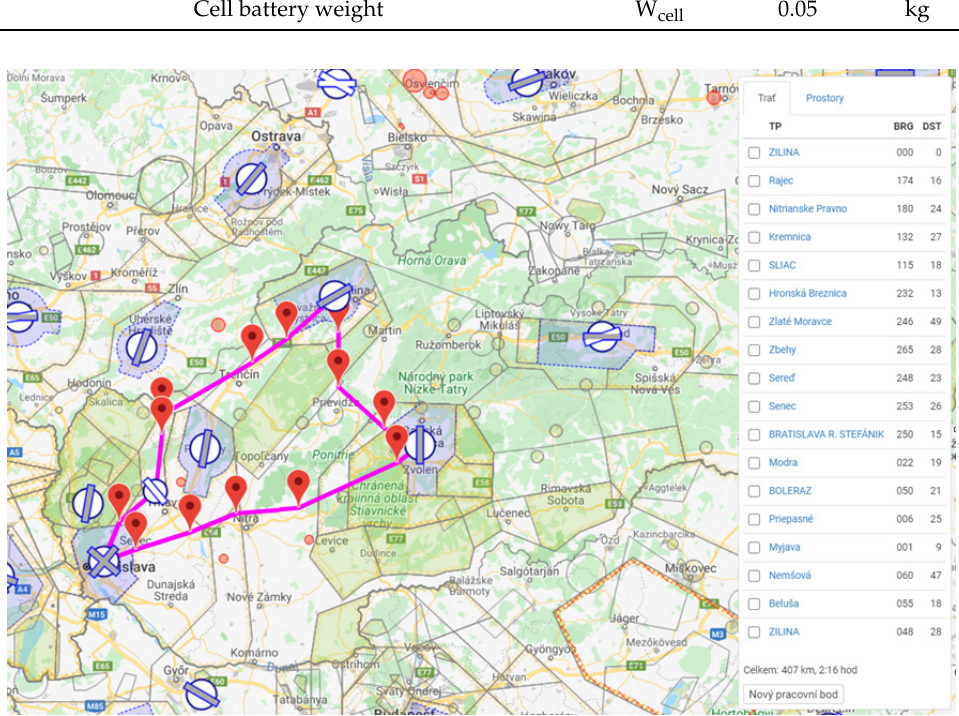
Figure 4. The training flight route for the considered theoretical design of the batteries of the aircraft’s serial hybrid system. Source: Authors.